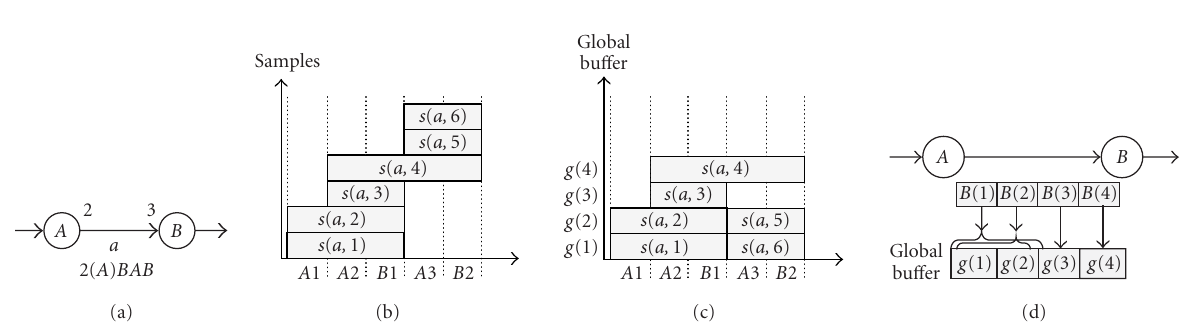
Figure 6: Interval scheduling algorithm.